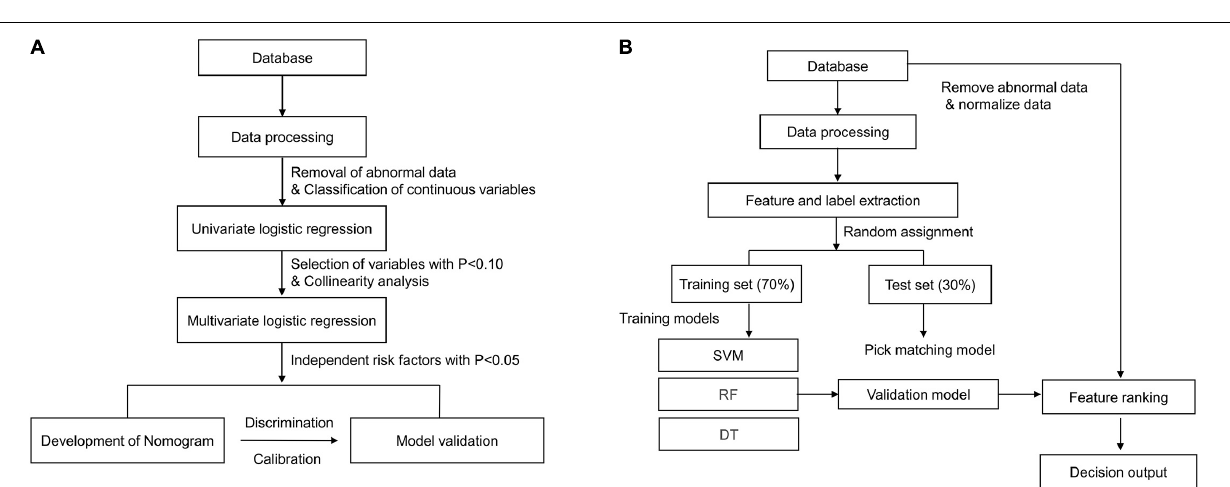
Statistics 22.0 and R software (R 4.0.2). Statistical significance was set at p < 0.05. The development process of the nomogram is shown in Figure 3A